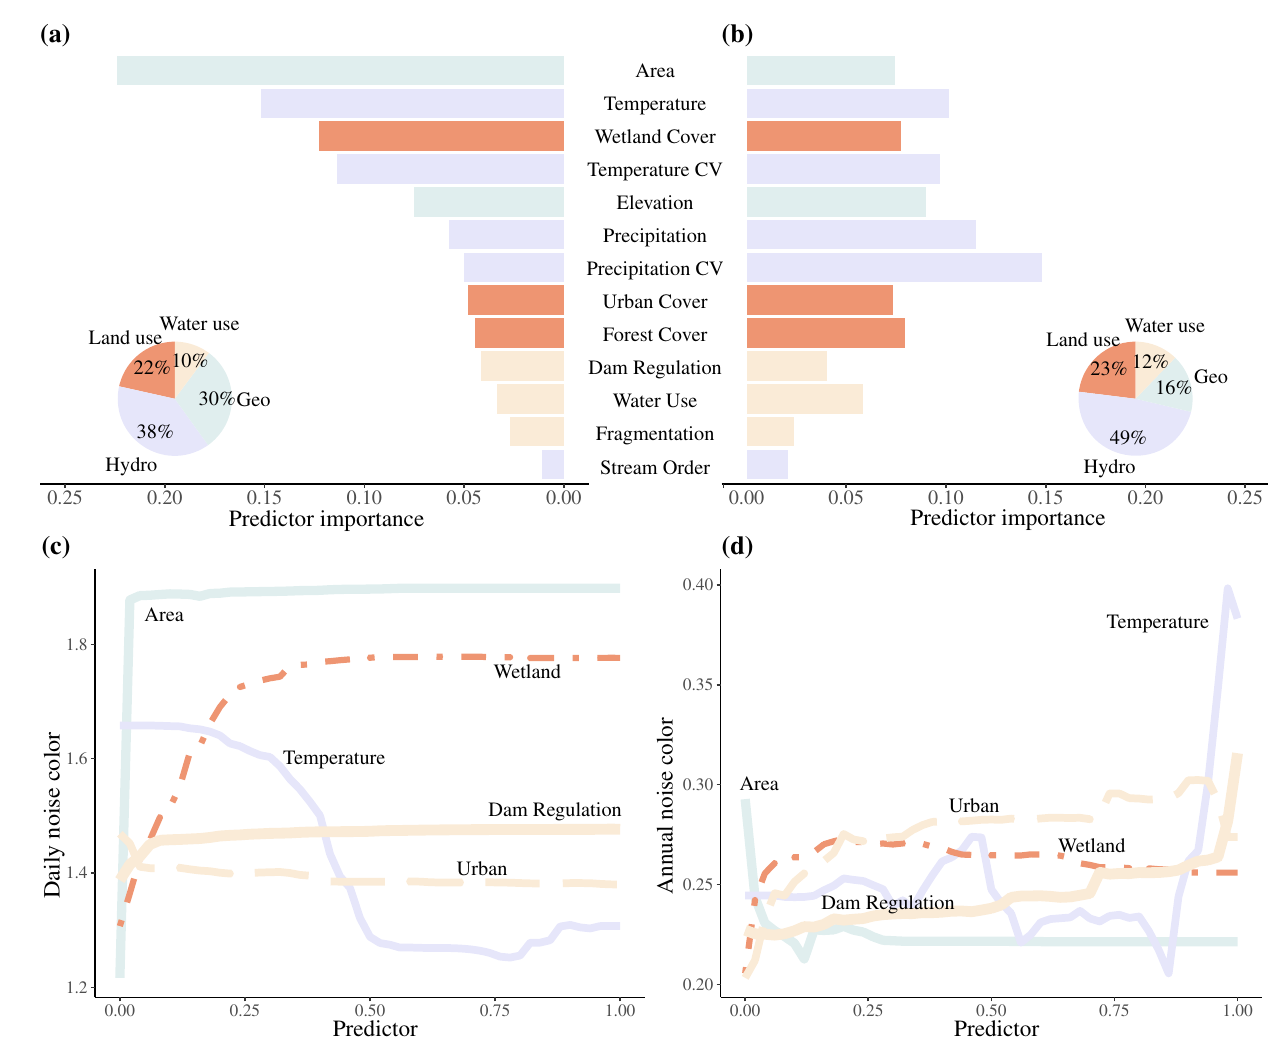
Fig. 3 | Environmental and human-related drivers of fl ow noise color. Relative importance of natural and anthropogenic drivers of fl ow noise color at the daily scale ( a ) and at the annual scale ( b ); and partial dependence plots of 5 selected driversondailynoisecolor( c )andannualnoisecolor( d ).Partialdependenceplots ( c , d ) show change in noise color attributed to each variable while removing the in fl uenceofothervariables.Thex-axesin c , d representthedimensionlessscalesof